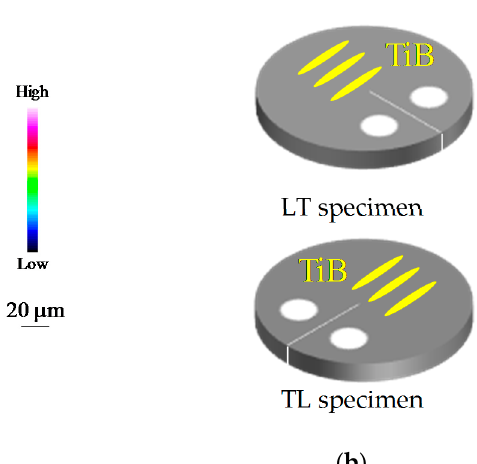
Figure 2. ( a ) Boron map obtained by electron probe micro analysis (EPMA) analysis for TiB/Ti-3Al-2.5V alloy; ( b ) Schematic illustration for the disk-shaped compact (DC(T)) specimens having different TiB orientations.